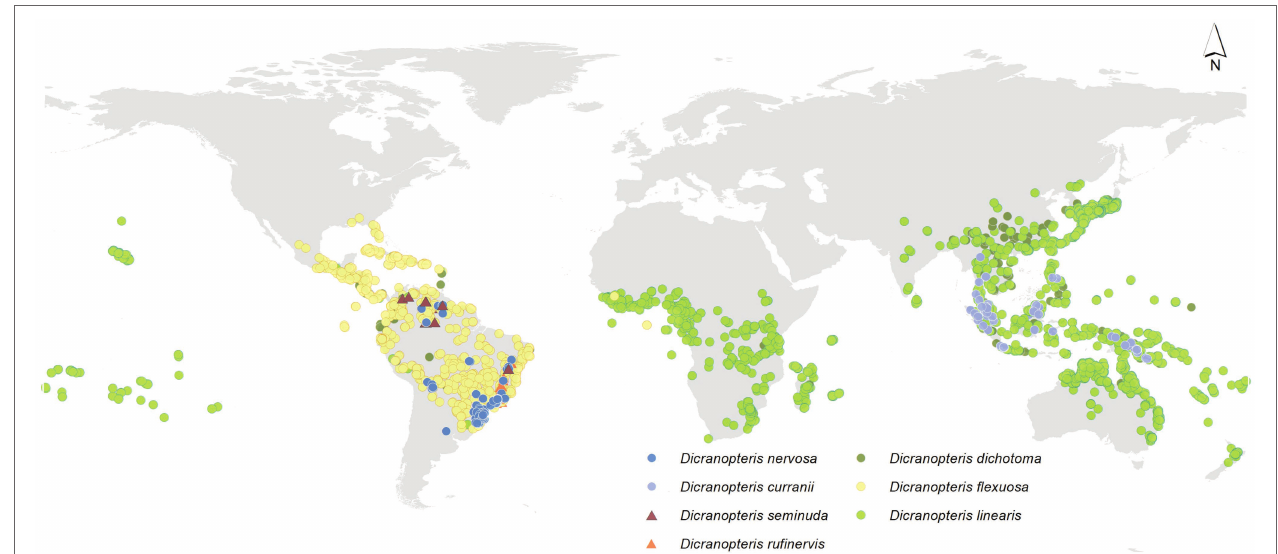
FIGURE 1 | Global distribution of Dicranopteris species, including Dicranopteris dichotoma (deep green dots), Dicranopteris curranii (shallow blue dots), Dicranopteris flexuosa (yellow dots), Dicranopteris seminuda (brown triangles), Dicranopteris nervosa (navy blue dots), Dicranopteris rufinervis (orange triangles), and Dicranopteris linearis (green dots). The distribution information was mainly obtained from Global Biodiversity Information Facility (gbif.org), sampling by Long Yang in East Asia and Lucas Vieira Lima in the